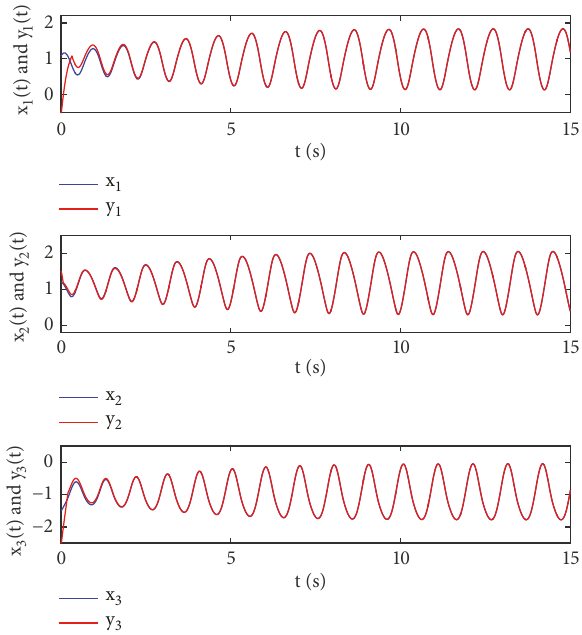
Figure 5: State trajectories of master-slave systems with 𝜉 =